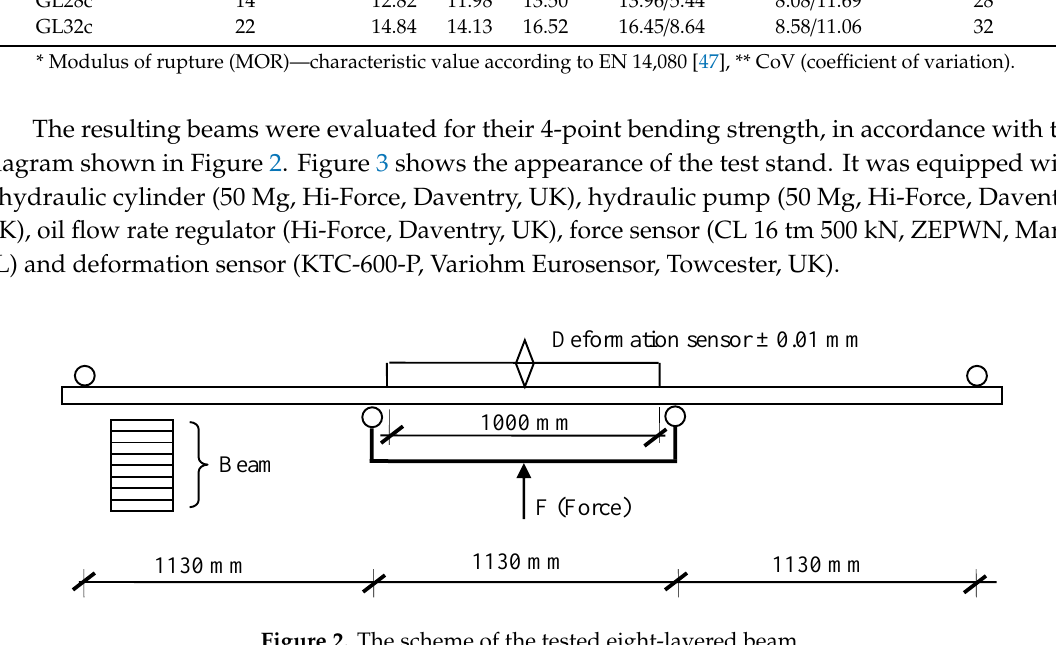
Table 1. Elastic properties of designed beams.